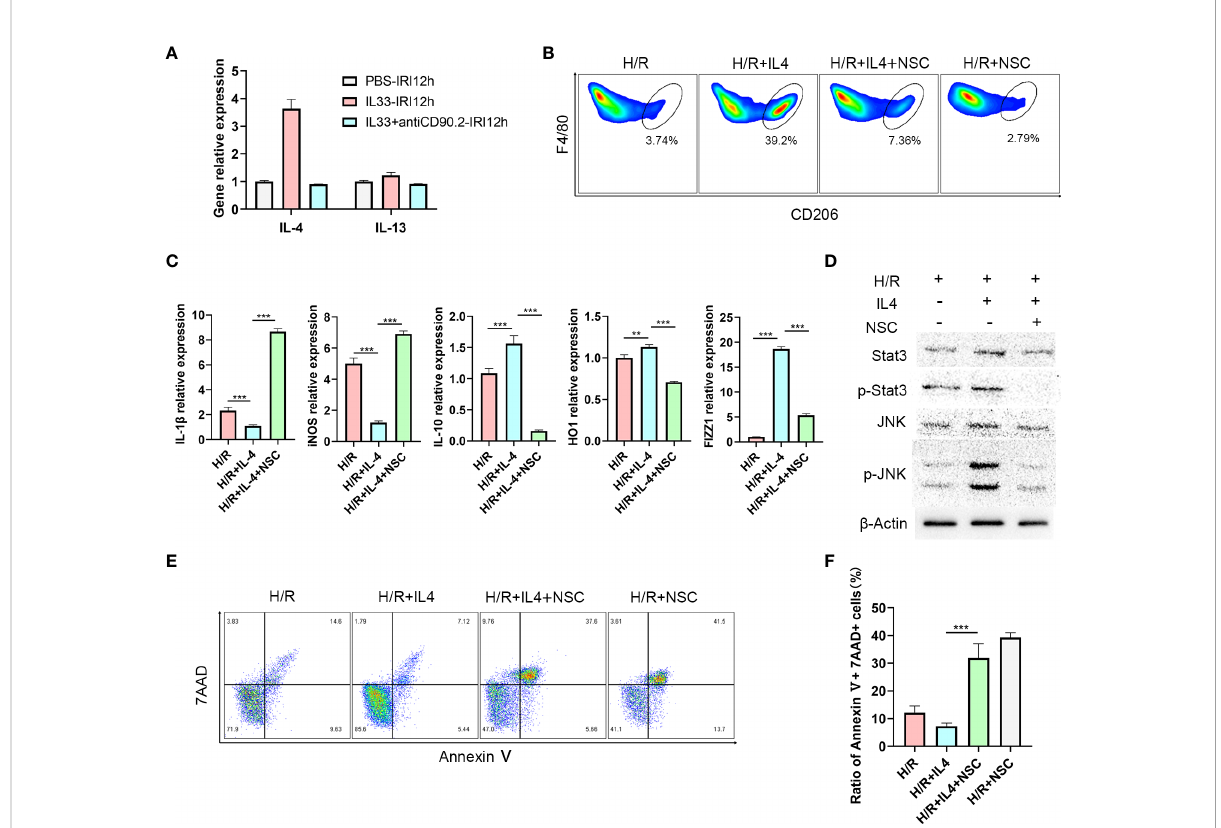
FIGURE 5 IL-4 polarizes CD45+CD11b+F4/80high macrophages to M2 type via the JNK/Stat3 pathway (A) Relative expression levels of IL-4 and IL13 mRNA in liver tissue of mice treated with IL-33 and IL-33+antiCD90.2 at 12 h following IRI. (B) Representative FACS analysis showing M2 CD45+CD11b+F4/ 80high macrophages proportion changes of treated with IL-4 or IL-4+Stat3 inhibitor NSC74859 (abbreviated as NSC) at 12 h following hypoxia and reoxygenation. (An increase CD206+ in proportion was assumed as a M2 polarization among CD45+CD11b+ F4/80high cells) (C) IL1 b , iNOS, HO-1, IL-10 and FIZZ-1 mRNA expression levels in macrophages within the different groups were determined using quantitative PCR. (D) Stat3, p-Stat3, JNK and p-JNK protein levels were assessed using western blot in RAW264.7 cells at 12 h after hypoxia and reoxygenation in the presence or absence of IL-4 or Stat3 inhibitor. (E) Apoptosis of AML12 cells after co-culture with different macrophages. (F) Histograms of quantitative analysis of 7AAD and Annexin V double positive cells. (** P <0.01, *** P